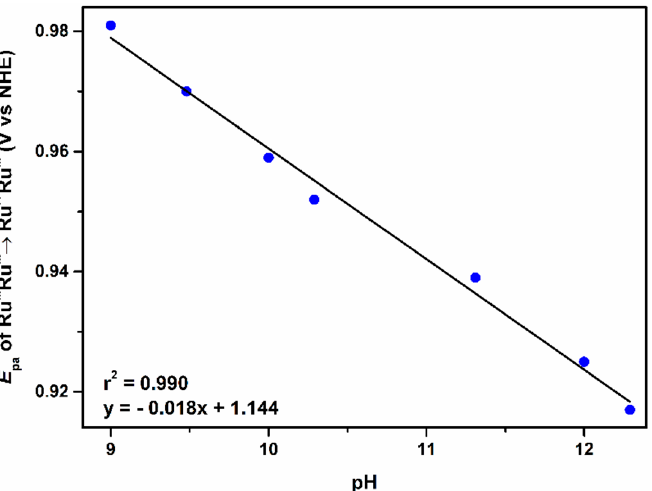
Figure 8. A plot of the anodic peak potential ( E pa ) of the Ru IV Ru III /Ru III Ru III redox couple vs. the pH of the medium. The voltammograms are recorded in 1.0 mM Na 3 [Ru 2 ( µ- CO 3 ) 4 ] and 0.10 M Na- HCO 3 aqueous solutions at different pHs with a scan rate of 50 mV·s − 1 under N 2